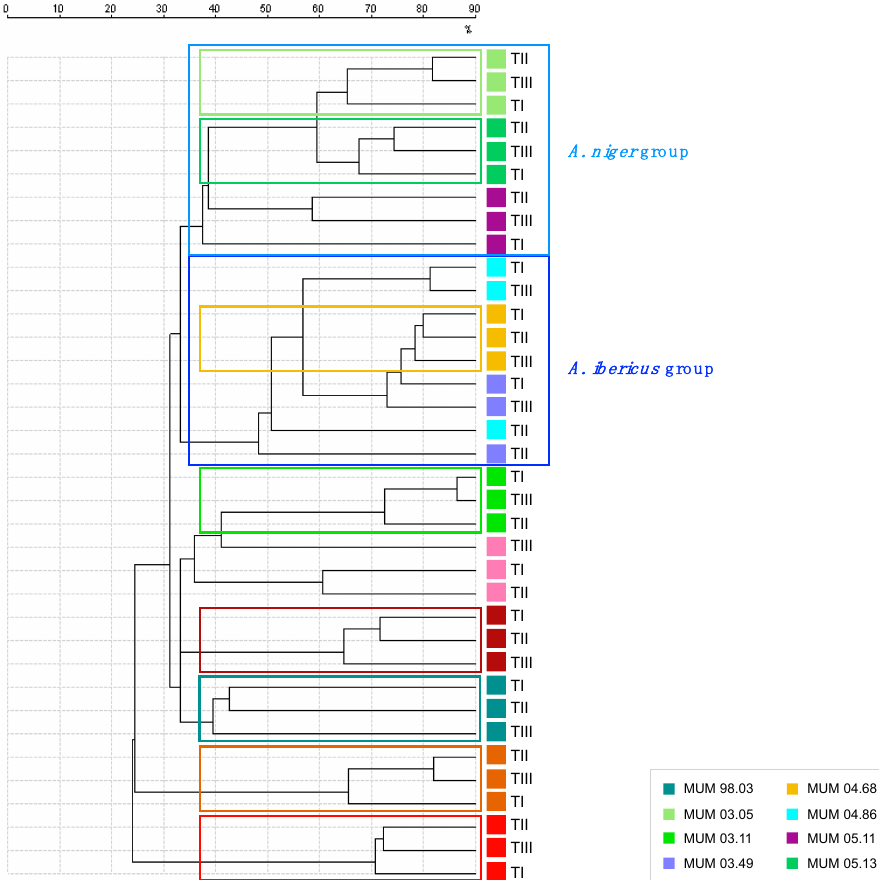
Figure 3. Dendrogram of proteomic relatedness with data from three preservation time points. TI—before preservation; TII—2 weeks of accelerated storage; and TIII—4 weeks of accelerated storage. Coloured boxes indicate strains where the three-time points cluster together.